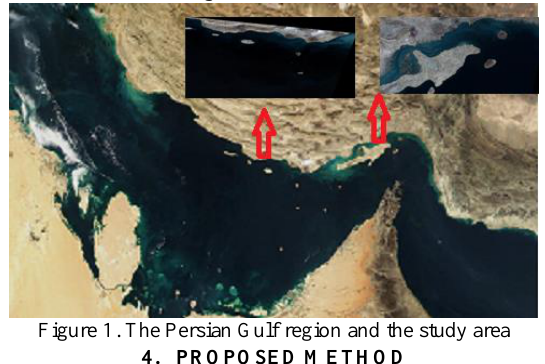
Ocean Color Algorithm (OCA) By